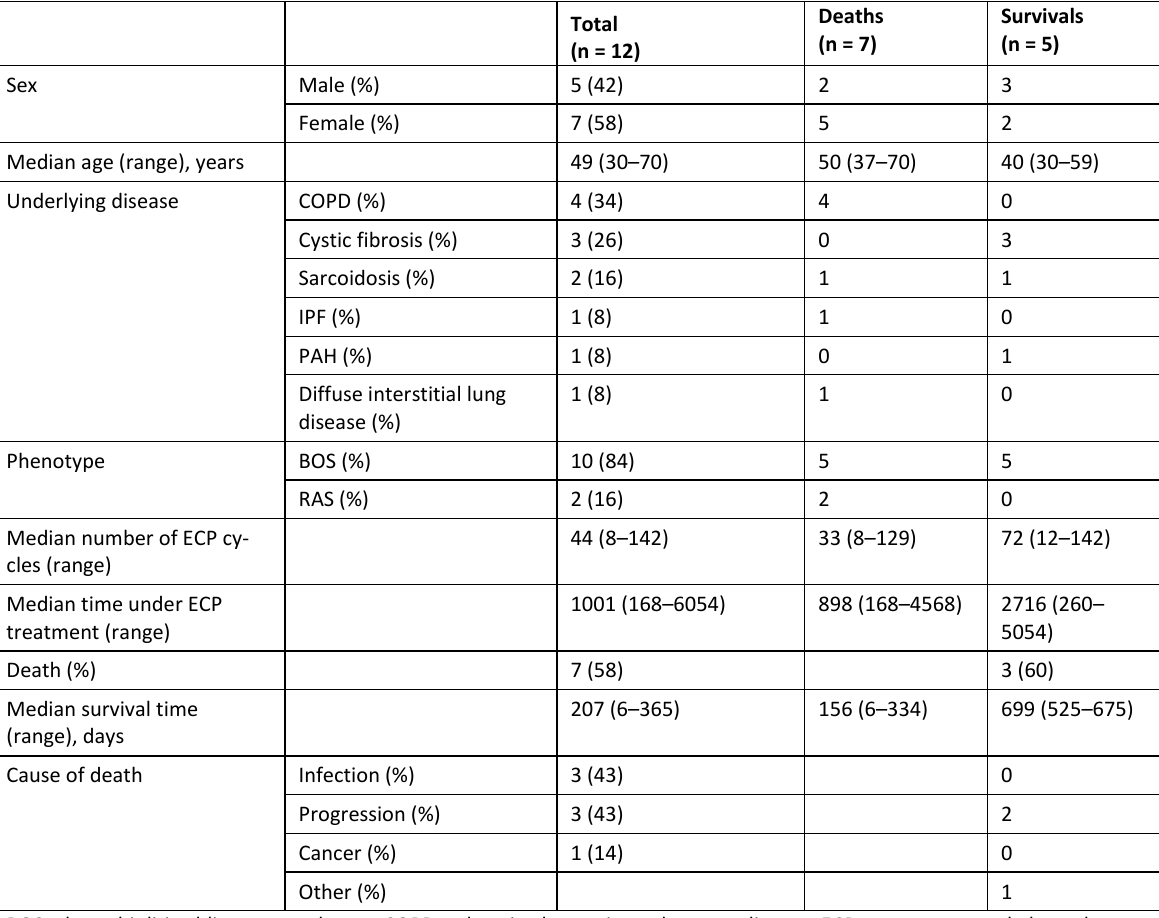
Table 1: Demographics for all patients (survival reported up to 12 months), for those who died within 12 months following ECP cessation and those who survived a minimum 12 months after ECP was stopped (survival reported until 30 November